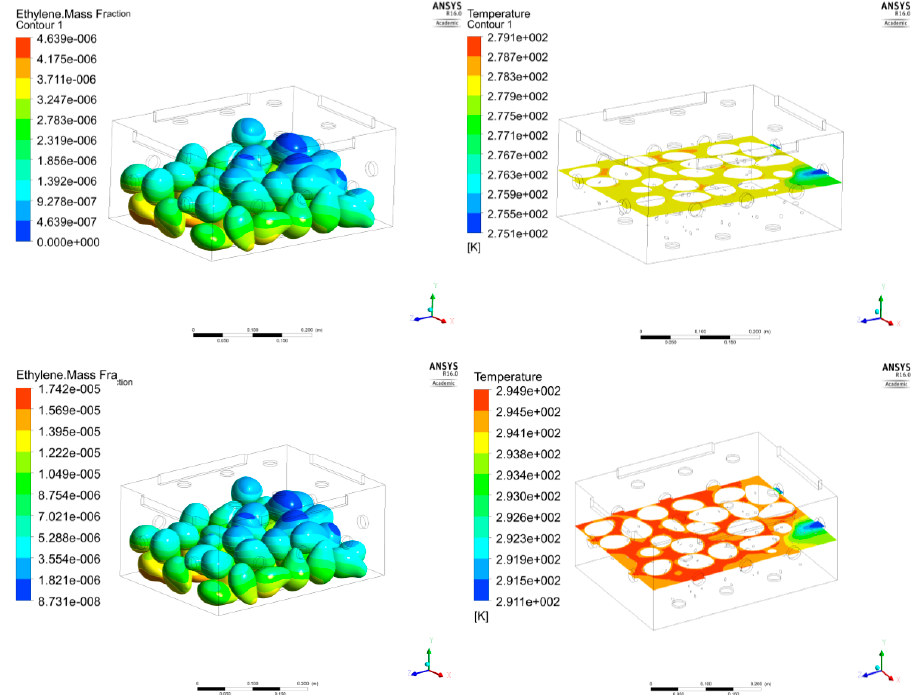
Figure 13. Contours of ethylene fraction and temperature for avocadoes at Re = 5 after 54 h of simulated storage time with airflow in the z direction. The top row is for storage temperature and bottom row for ambient temperature.